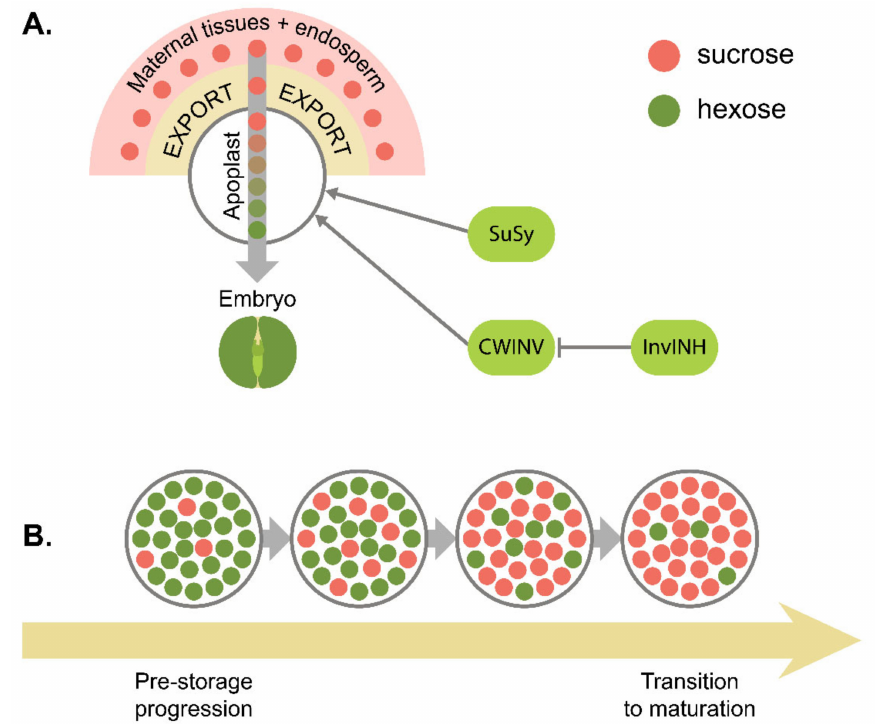
Figure 5. A representation of the ‘invertase control hypothesis’ as proposed for legumes. ( A ) General scheme of low-molecular sugars’ flow in legume seeds at the patterning phase. ( B ) Dynamics of hexose and sucrose sugars in embryonic tissues. A decrease of cell wall invertases and SuSy activity leads to a fall of hexose/sucrose ratio, which serves as a metabolic signal for the maturation